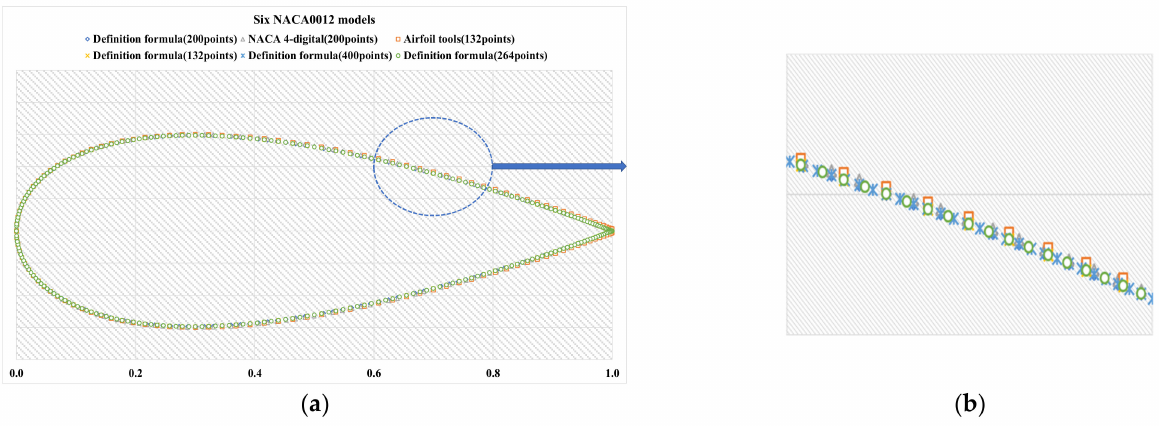
Figure 1. ( a ) Six NACA0012 airfoil models; ( b ) Close view of different